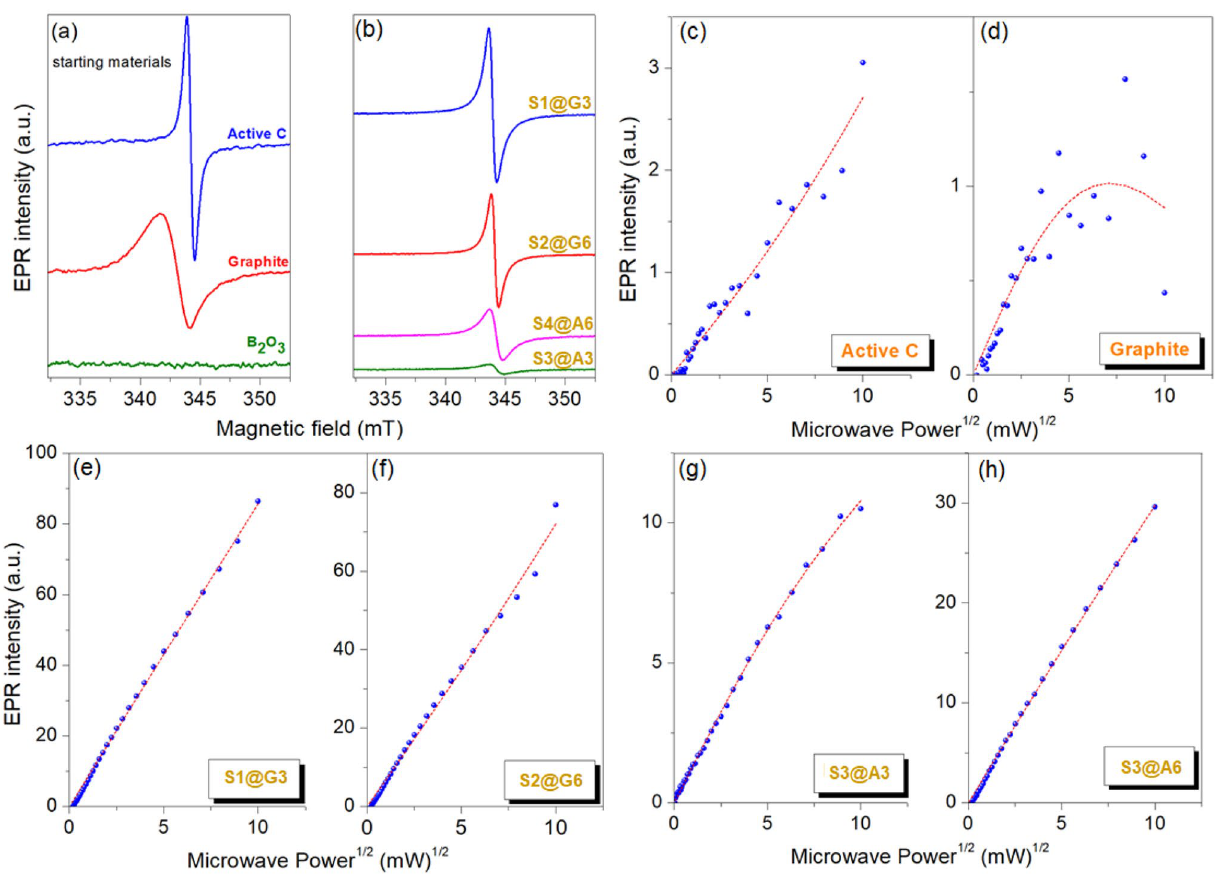
Figure 5. ( a , b ) X-band continuous wave EPR results and, ( c – h ) experimental and fitted EPR power saturation curves for starting materials and B 4 C samples.